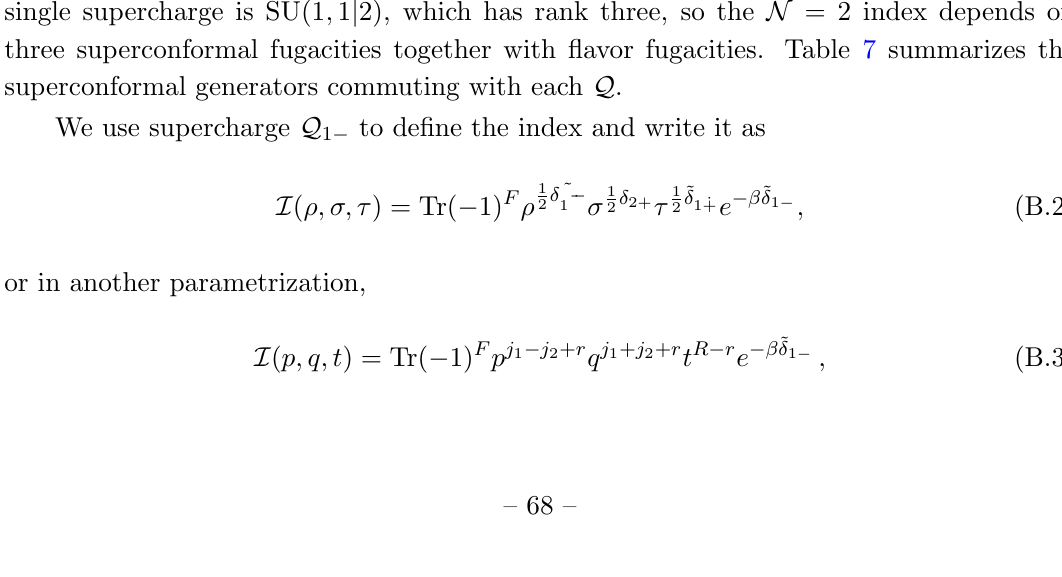
where Q is the supercharge \with respect to which" the index is calculated and f T complete set of generators that commute with Q and with each